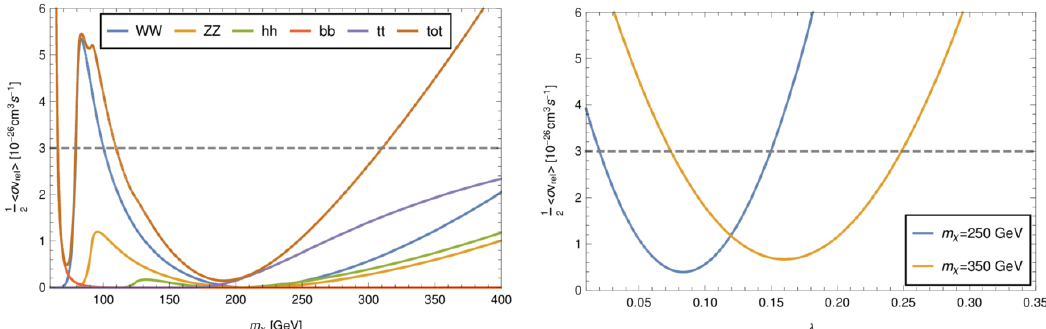
Figure 6 . Thermally averaged cross section for DM annihilation. The gray dashed line shows the value required to reproduce the present relic abundance according to the approximate relation in eq. (4.7). The scale f was (cid:12)xed to 1 : 4 TeV. In the left panel we set the portal coupling to the representative value (cid:21) = 0 : 05, in the right panel we chose two representative values of the DM mass. In both panels the t (cid:22) th and t (cid:22) t(cid:31) (cid:3) (cid:31) couplings were set to their sigma model values (eq. (4.6)), thus neglecting top partner mixing. With this simpli(cid:12)cation, h (cid:27)v rel i is completely determined by f; m (cid:31) and (cid:21)